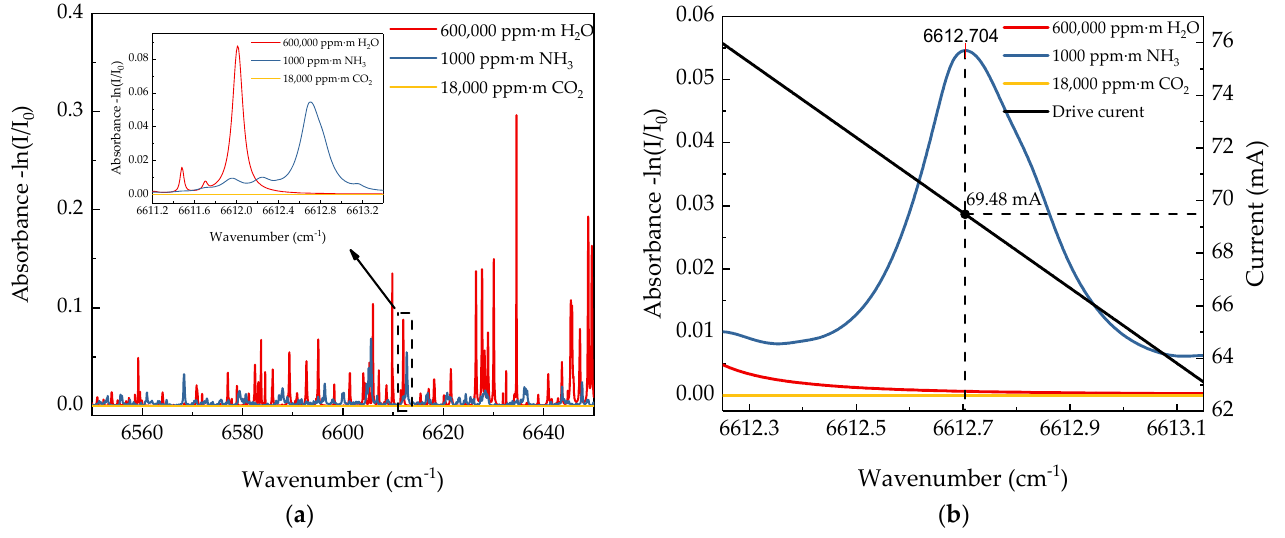
Figure 1. ( a ) Absorption spectra of NH 3 , H 2 O, CO 2 from 6550 cm − 1 to 6650 cm − 1 . ( b ) Absorption spectra of NH 3 (1000 ppm·m, blue line), H 2 O (1%, red line), and CO 2 (0.03%, yellow line) at an optical path of 60 m based on HITRAN database and the plot of drive current versus wavenumber of the distributed feedback (DFB) laser (black line), the value of modulation current at the central wavenumber 6612.7 cm − 1 is 69.48 mA.